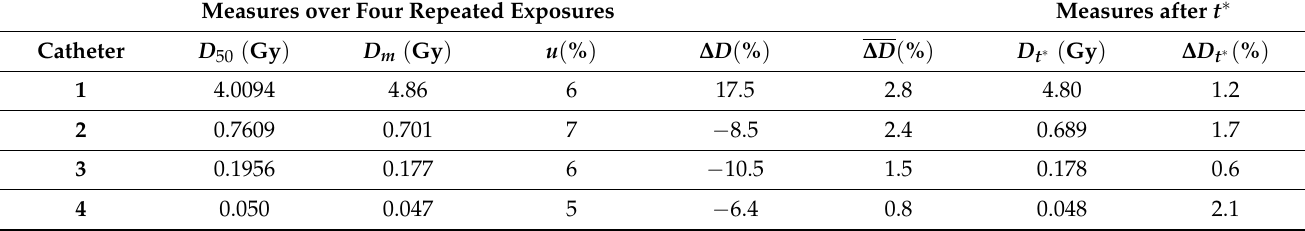
Table 7. D m over four subsequent exposures compared to TPS calculated dose D 50 (left) and measured doses D m for a single exposure performed after 1 week (right) for the plan with a single active position in C1. The relative standard uncertainty u (%) with k = 2 is also shown along with percent differences.